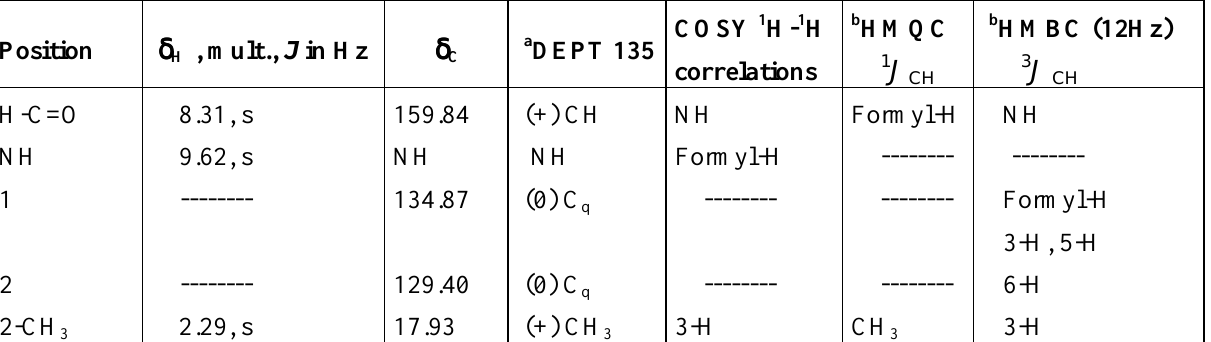
Table 3. 1 H(400 MHz) and 13 C NMR (100MHz) Spectral Data for 5 - cis in DMSO- d